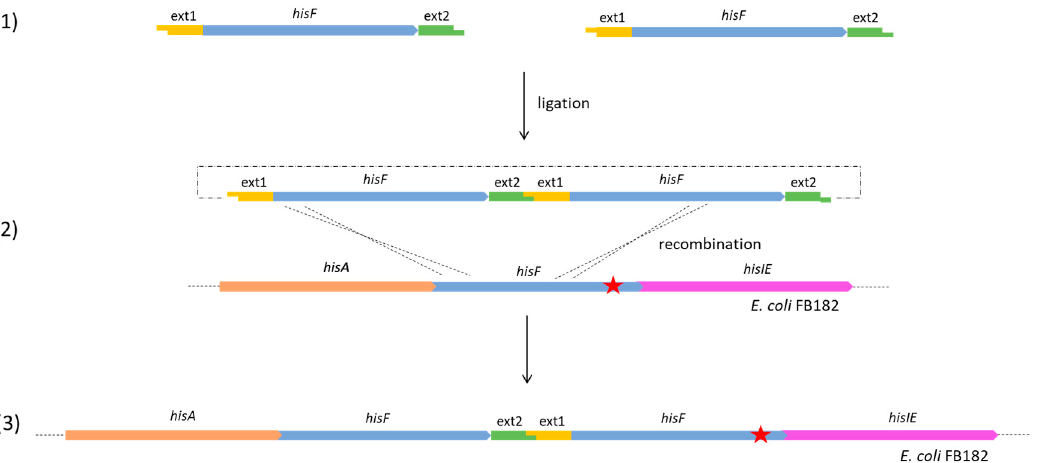
Figure 3. A possible molecular rearrangement leading to a His + clone harboring two in tandem hisF